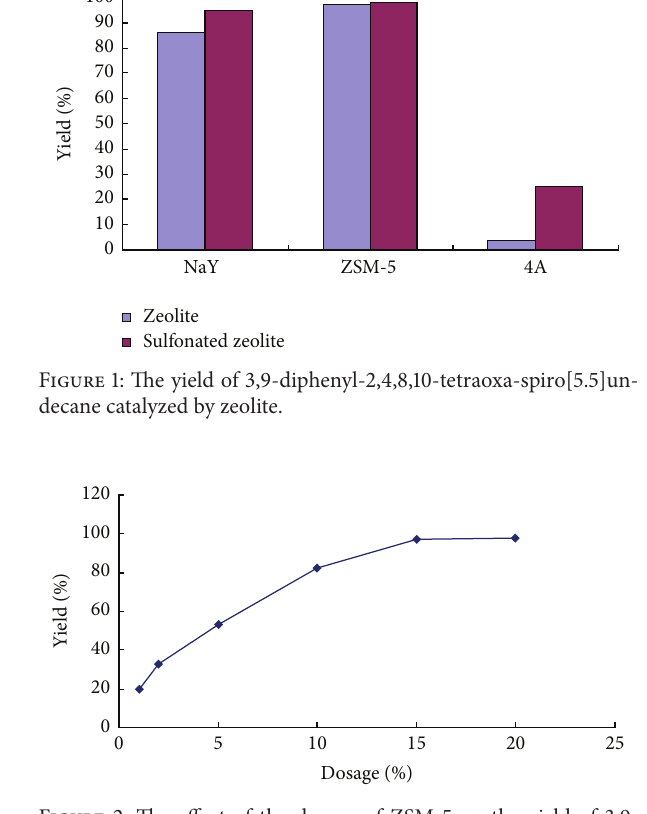
Figure 2: The effect of the dosage of ZSM-5 on the yield of 3,9-